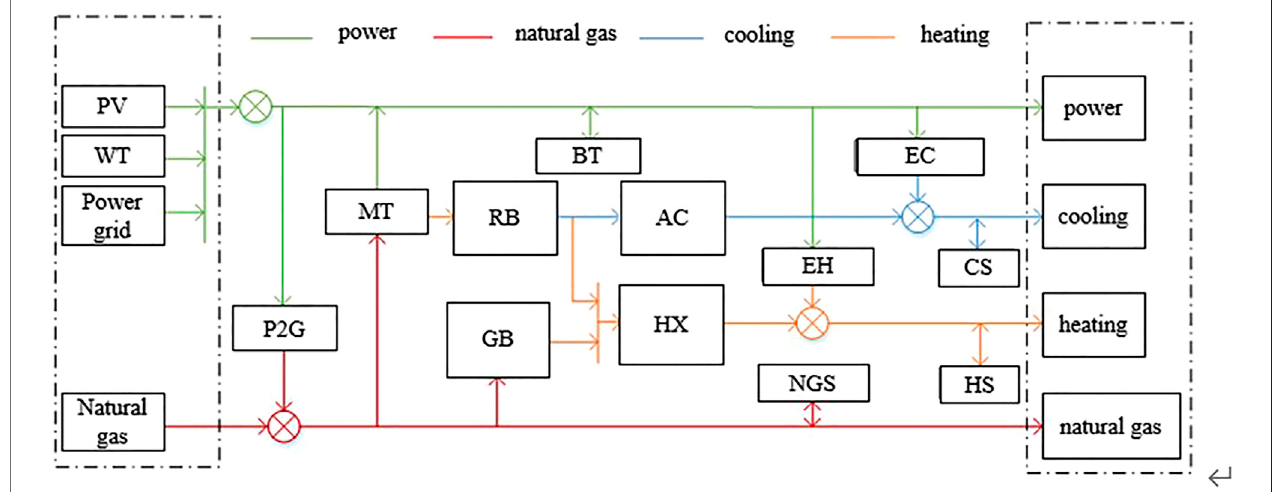
FIGURE 1 | The integrated energy system